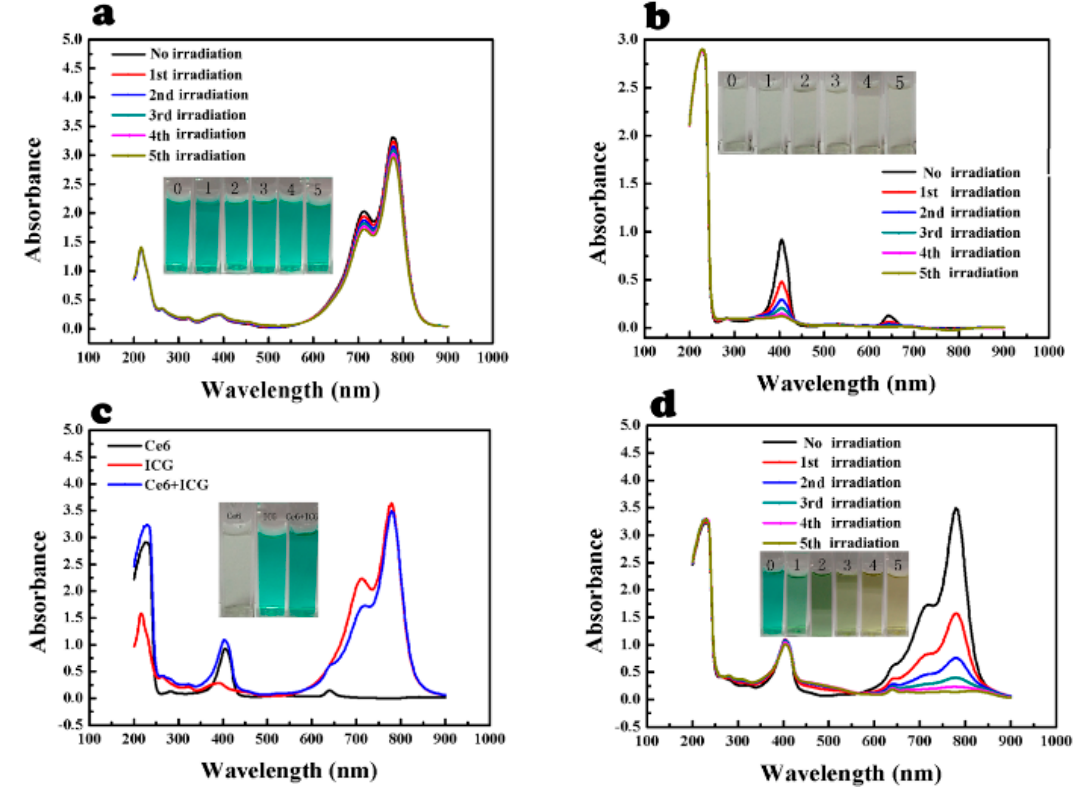
Figure 1. Feasibility of ICG to detect 1 O 2 . ( a ) ICG under laser irradiation; ( b ) Ce6 under laser irradiation; ( c ) ICG, Ce6 and ICG with Ce6; ( d ) ICG with Ce6 under laser irradiation.